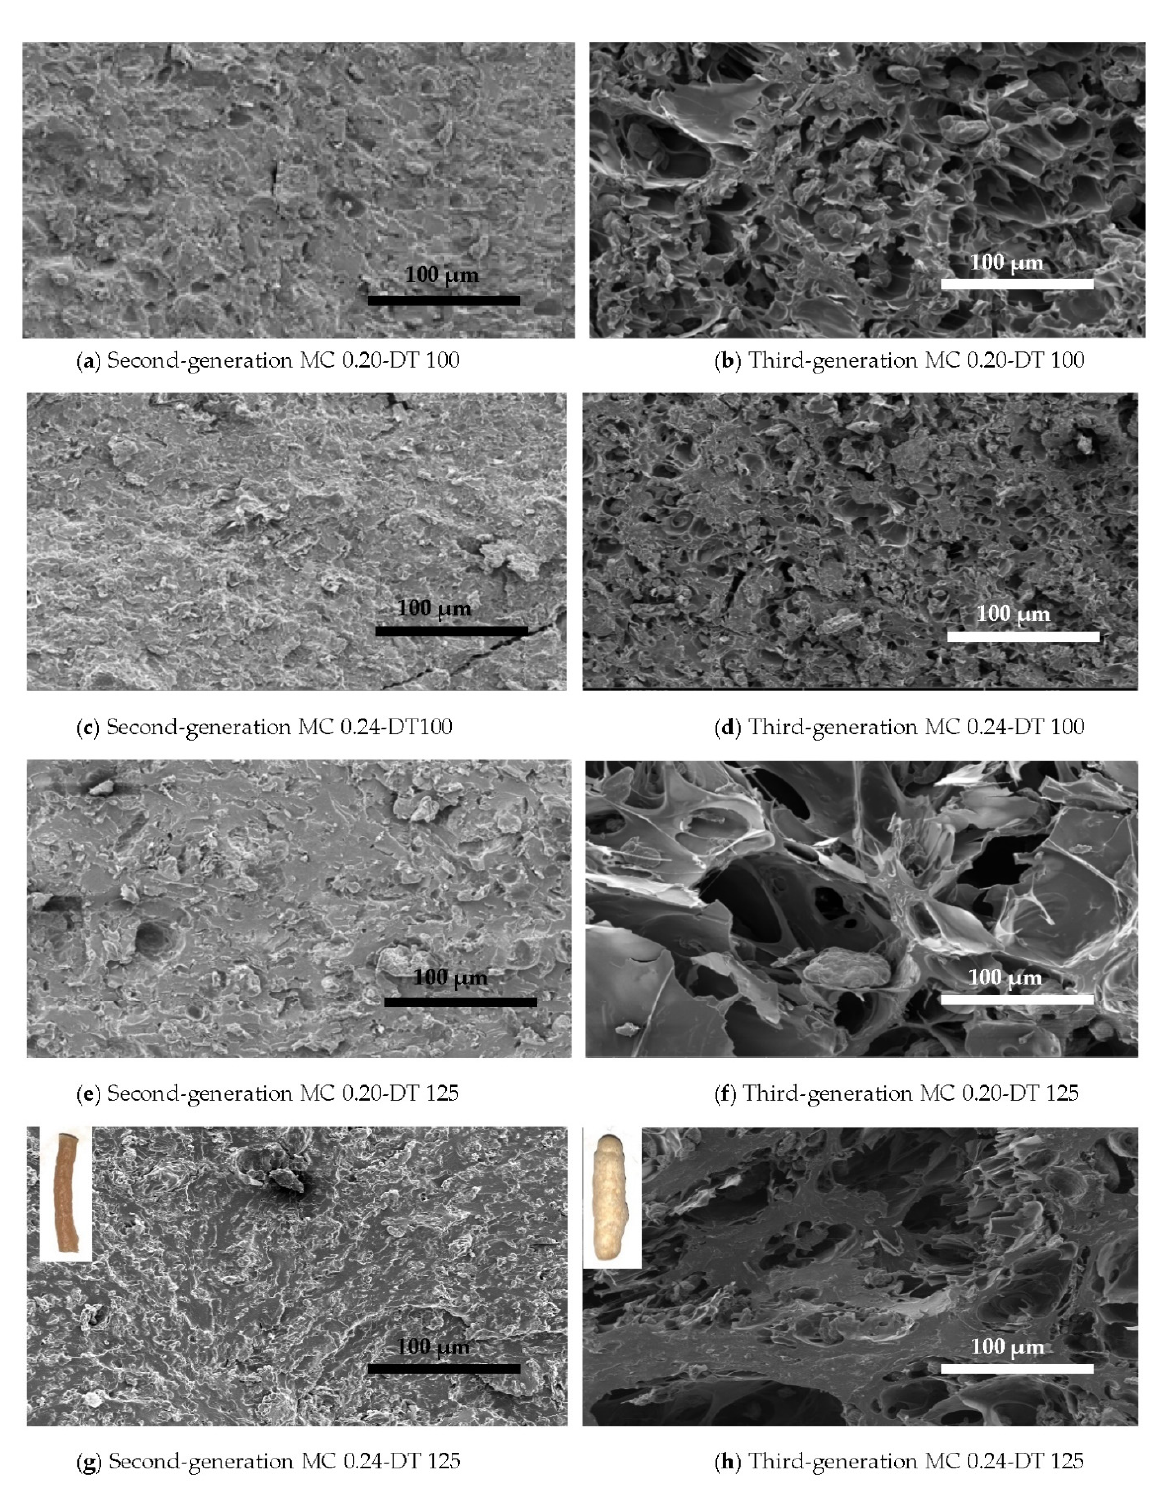
Figure 2. Scanning electron micrographs of second-generation (first column) and third-generation (second column) red lentil products with feed moisture contents of 0.20 and 0.24 kg water per kg dry flour (MC 0.20 and MC 0.24, respectively) at 100 °C and 125 °C die temperature (DT 100 and DT 125, respectively). A 250 × magnification was used for all images with a scale bar of 100 µm shown. Digital images in ( g ) and ( h ) show red lentil second- and third-generation products, respectively, produced with MC of 0.24 at 125 °C.